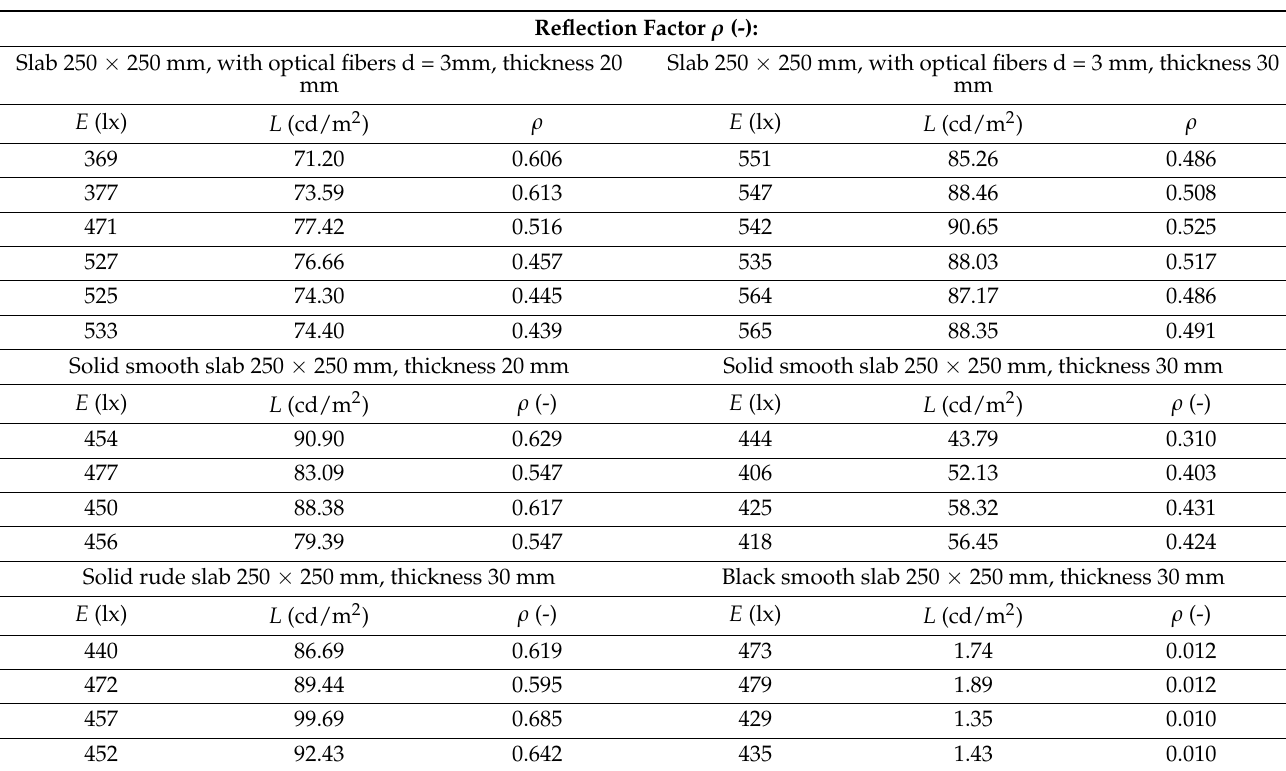
Table 10. Reflection factor ρ (-). Reflection Factor ρ